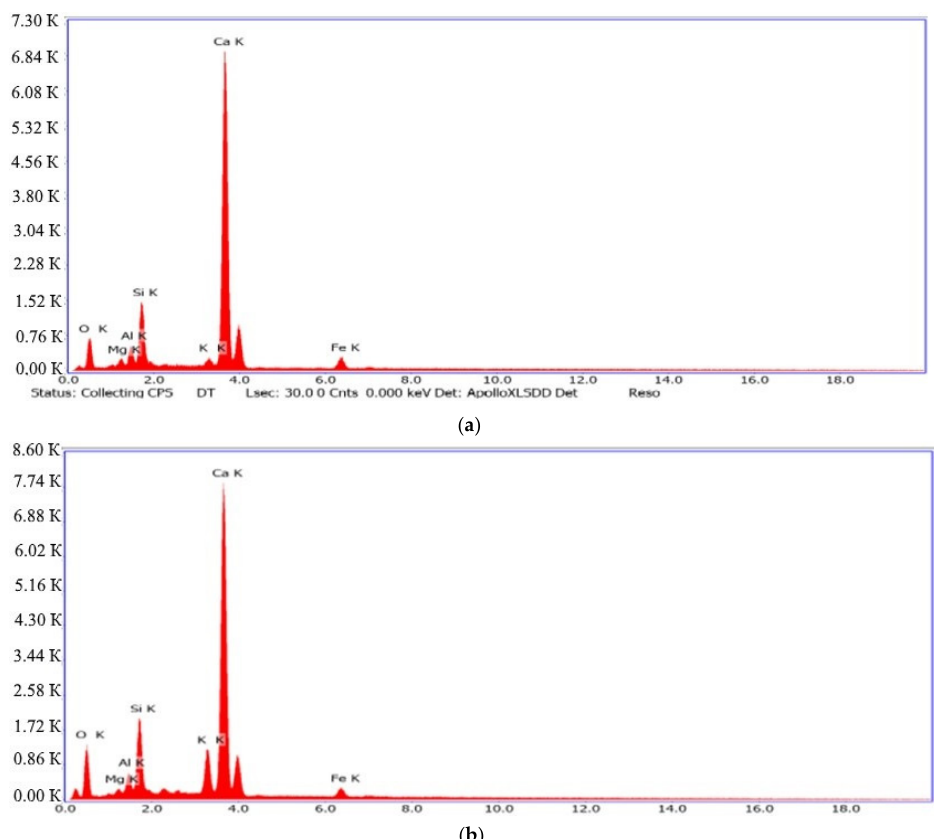
Figure 3. EDS spectra phases of the dusts: ( a ) clinker, and ( b ) aspiration.